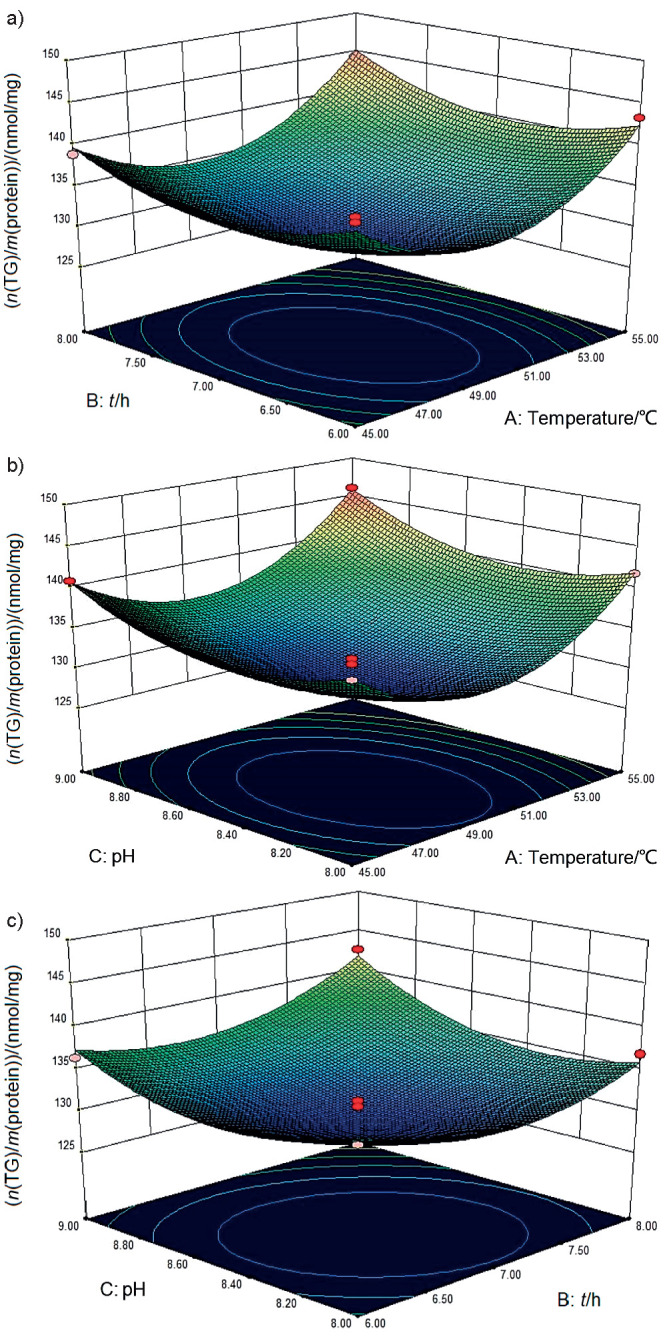
Effects of cross-interaction among the three parameters on the degree of hydrolysis of trypsin: a) pH values and temperatures, b) pH values and enzyme-to-substrate ratio, and c) temperature and enzyme-to-substrate ratio